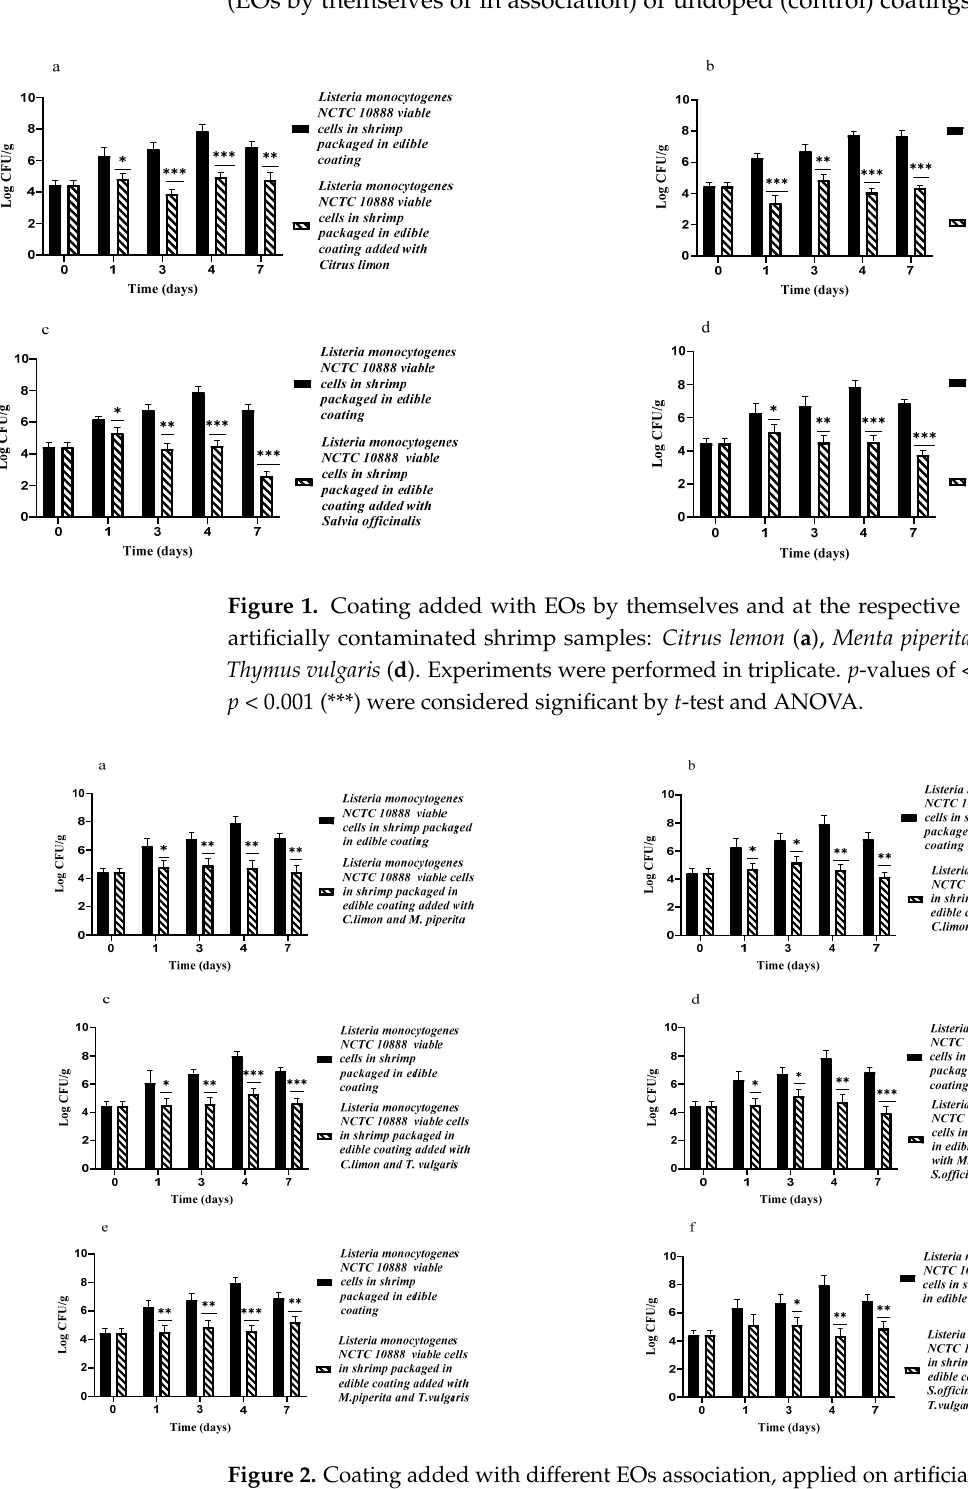
Figure 2. Coating added with different EOs association, applied on artificially contaminated shrimp sam- ples: C. limon / M. piperita ( a ), C. limon / S. officinalis ( b ), C. limon / T. vulgaris ( c ), M. piperita / S. officinalis ( d ), M. piperita / T. vulgaris ( e ) and S. officinalis / T. vulgaris ( f ). Experiments were performed in triplicate. p -values of < 0.05 (*), p < 0.01 (**) and p < 0.001 (***) were considered significant by t -test and ANOVA.